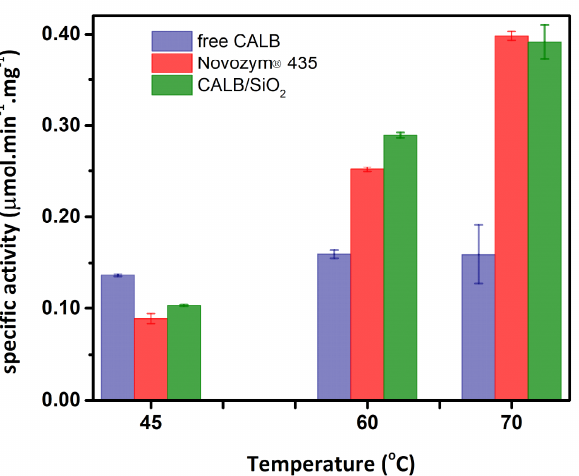
Figure 10. Specific activity of free CALB, Novozym → 435 and CALB lipase immobilized on Ns SiO 2 (0.028 µmol.m −2 ) in the esterification of rac -ibuprofen with ethanol at 45 °C, 60 °C and 70 °C (0.028 µ mol.m − 2 ) in the esterification of rac -ibuprofen with ethanol at 45 ◦ C, 60 ◦ C and 70 ◦ C for 9 for 9 h.